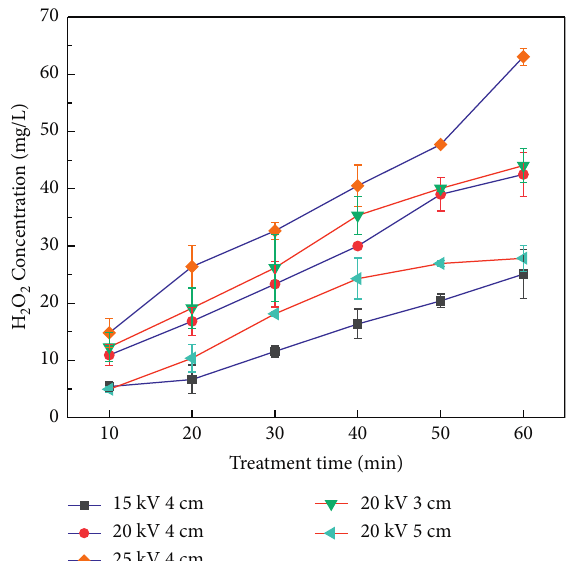
Figure 12: H 2 O 2 concentrations at voltages of 15, 20, and 25kV and the needle-dielectric plate distance of 4cm and the needle-dielectric plate distance of 3 and 5 cm and voltage of 20 kV.